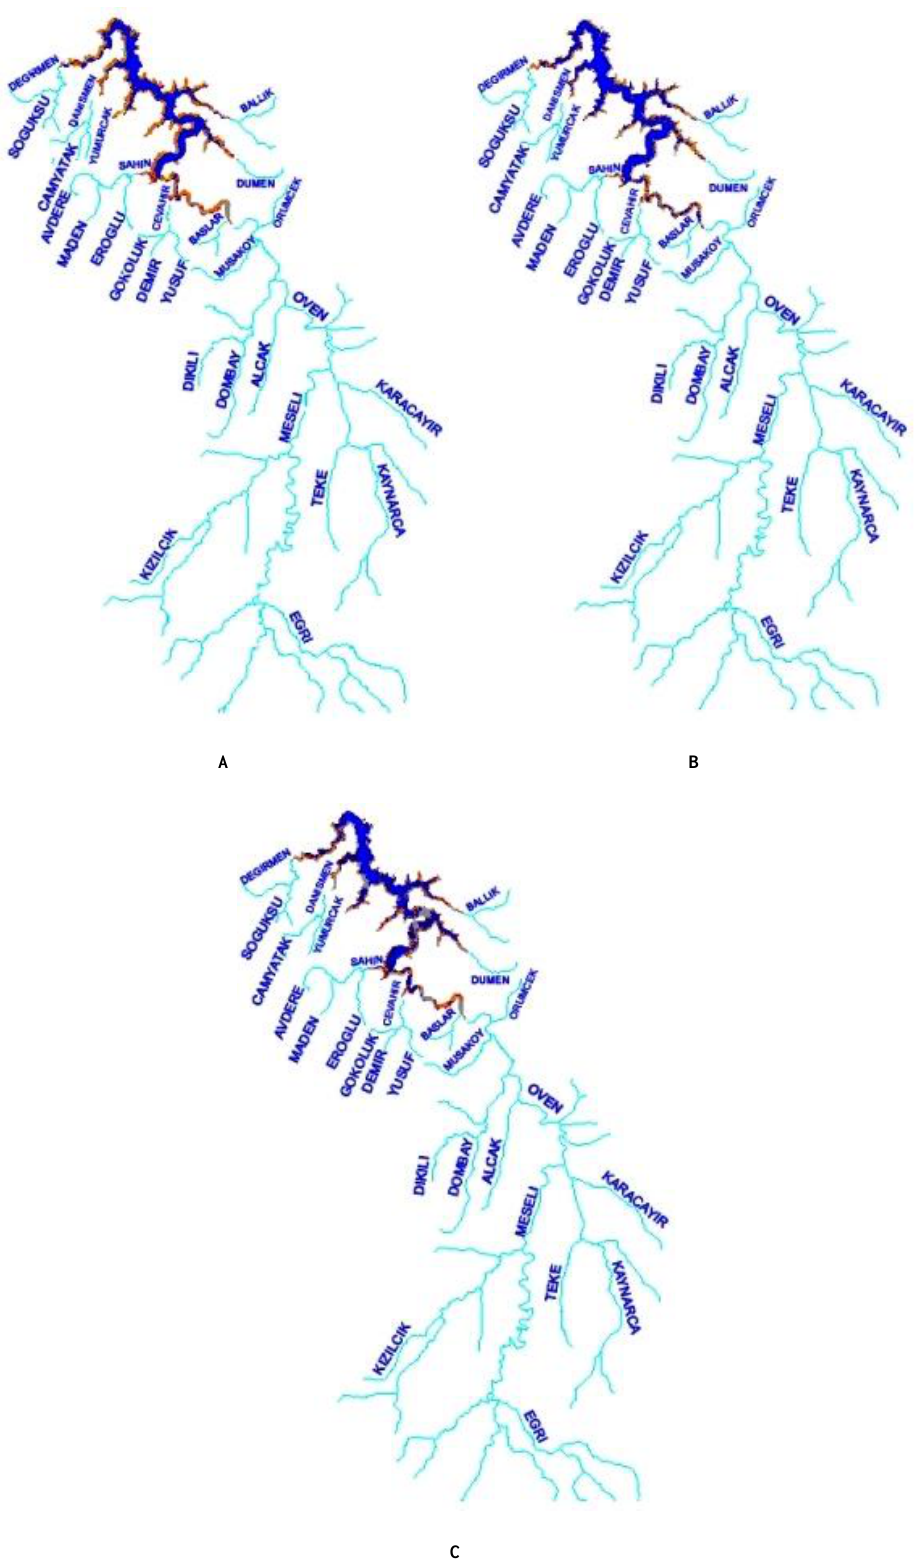
FIGURE 5. WQ images by pattern recognition techniques. (A) 2004, (B) 2005, (C)